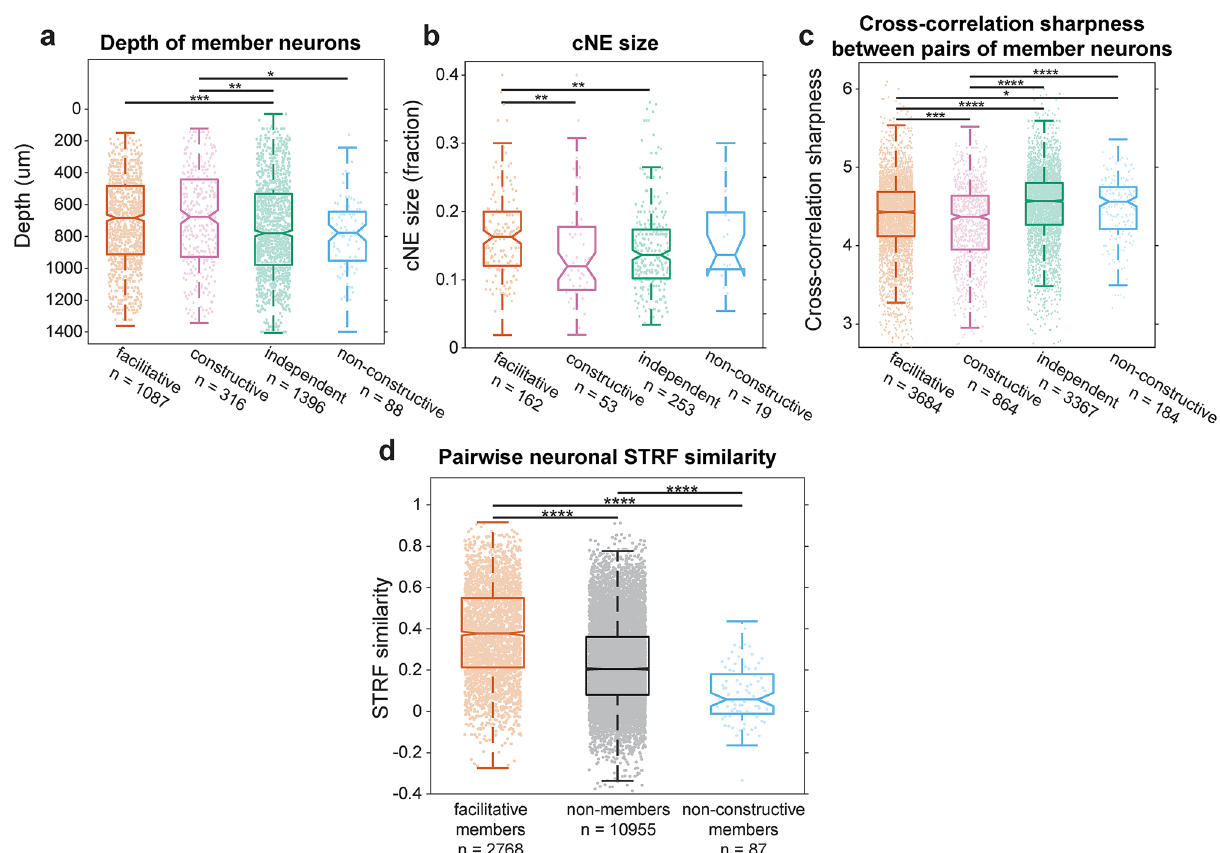
Figure 4. Functional and physical properties of cNE categories. ( a ) Depth of member neurons between different types of cNEs. Constructive and facilitative cNEs were found at a shallower depth than stimulus- independent and non-constructive cNEs. ( b ) cNE size, calculated by the number of neuronal members as a fraction of the total number of neurons recorded. Facilitative cNEs were larger than constructive or stimulus- independent cNEs. ( c ) Cross-correlation sharpness (see “Methods”) between pairs of neurons from the same cNE. Stimulus-independent and non-constructive cNEs had broader cross-correlation functions than facilitative or constructive cNEs. ( d ) STRF similarity between pairs of STRF + neurons within the same facilitative cNE, non-constructive cNEs, and neurons that were not part of the same cNE but recorded simultaneously. Facilitative cNE members had more similar STRFs than that of non-members while non-constructive cNE members had less similar STRFs that that of non-members. *p < 0.05, **p < 0.01, ***p < 0.001, ****p < 0.0001; Kruskal–Wallis test with Bonferroni